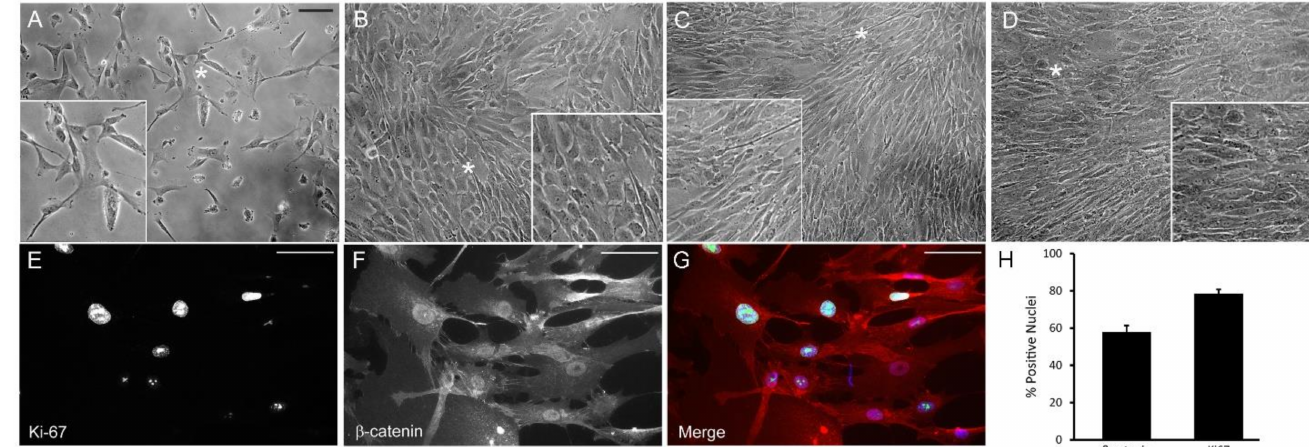
Figure 2. Proliferating HTM cells demonstrate nuclear labeling for Ki-67 and β -catenin. ( A ) Sparse HTM cells in culture. Bar = 100 µ m. ( B ) HTM cells one day prior to reaching confluence. ( C ) HTM cells upon reaching confluence. ( D ) HTM cells 7 days post confluence. ( E , G ) Subconfluent HTM cells demonstrate nuclear labeling for Ki-67 (green). Bar = 50 µ m. ( F , G ) Subconfluent HTM cells demonstrate nuclear labeling for β -catenin (red). ( H ) Quantification of the percentage of subconfluent HTM cells demonstrating nuclear labeling for Ki-67 or β -catenin. Asterisk in panels indicates area enlarged in